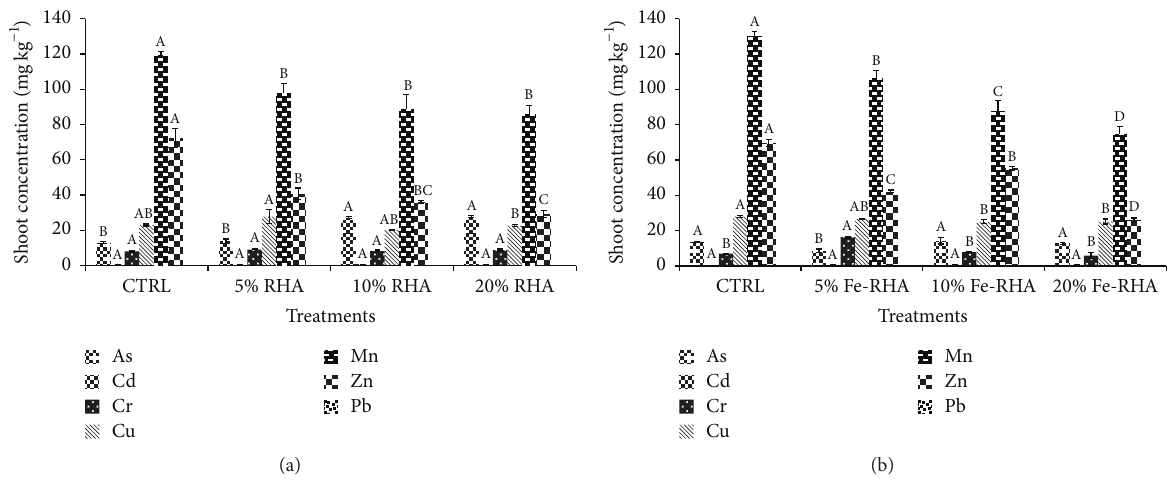
Figure 3: Concentration (mgkg −1 ) of As, Cd, Cr, Cu, Mn, Zn, and Pb in shoot of vetiver grass grown in gold mine amended with (a) RHA and (b) Fe-RHA (mean 𝑛 = 3 , ± SD). Different letters correspond to significant differences between rates of the same ash ( 𝑃 < 0.05 ). Pb was not